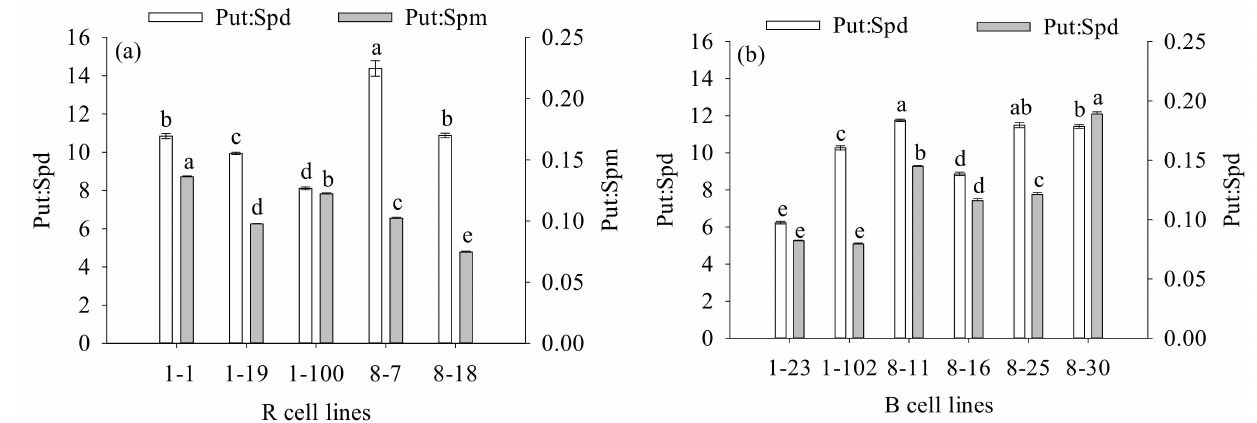
Figure 14. Differences in the Put: Spd and Put: Spm ratios between different cell lines of P. koraiensis. ( a ) R cell lines; ( b ) B cell lines. Different letters above the column indicate significant differences at the p < 0.05